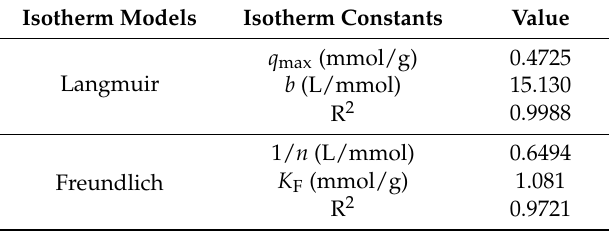
Figure 13 . ( a ) Langmuir and ( b ) Freundlich isotherm models for the adsorption of EDTA on AERs in EDTA/Cs (1:1) mixed solution. [AERs] = 2 g/L; [EDTA] = 0.01–0.5 mM; adsorption time = 5 h. Table 2. Langmuir and Freundlich constants for the adsorption of EDTA on AERs. Isotherm Models Isotherm Constants